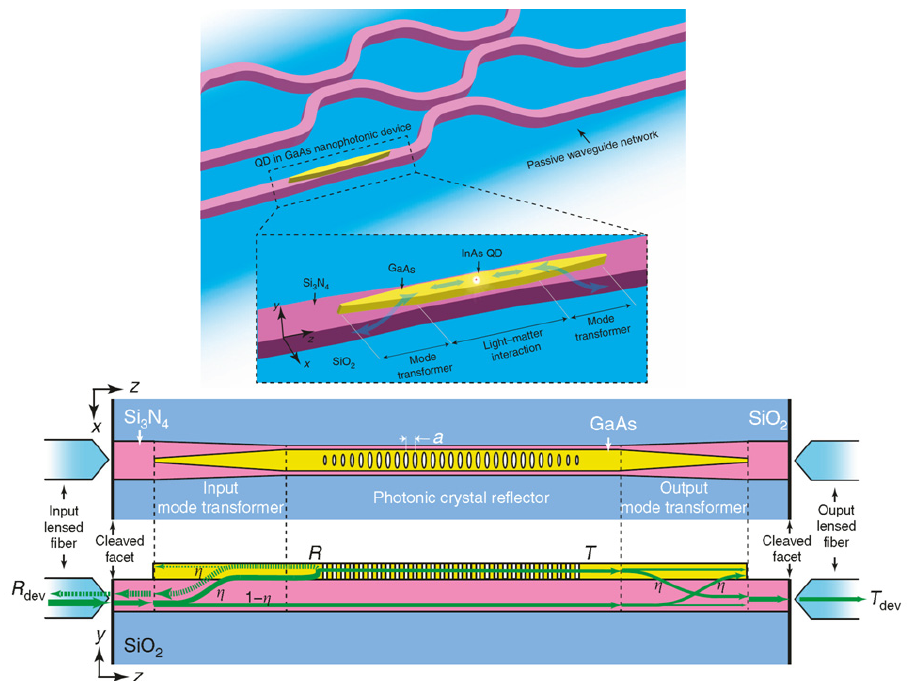
Figure 7. Conceptual quantum photonic circuit composed of a passive waveguide network with a directly integrated GaAs nanophotonic device (exemplified by a nanowaveguide) containing a single quantum dot. In the bottom part of figure, the schematic of a PhC reflector device is shown [46].